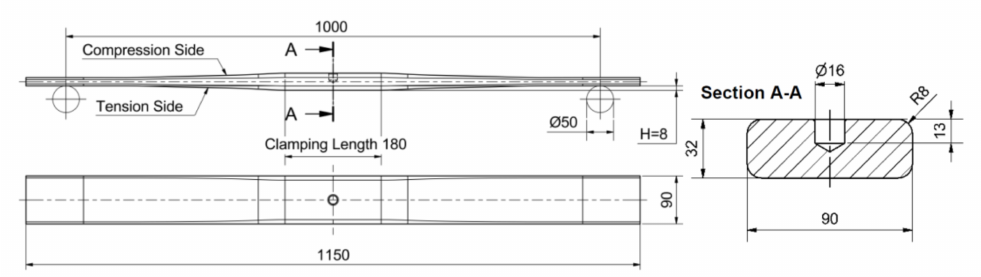
Figure 1. Technical drawing of the parabolic leaf spring specimens—dimension in [mm]. Table 2. Thickness of the leaf spring at various positions measured from the leaf centre.